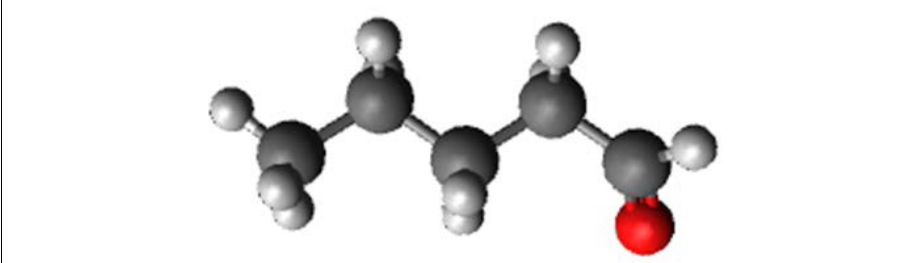
Figure 1: The arrangement of